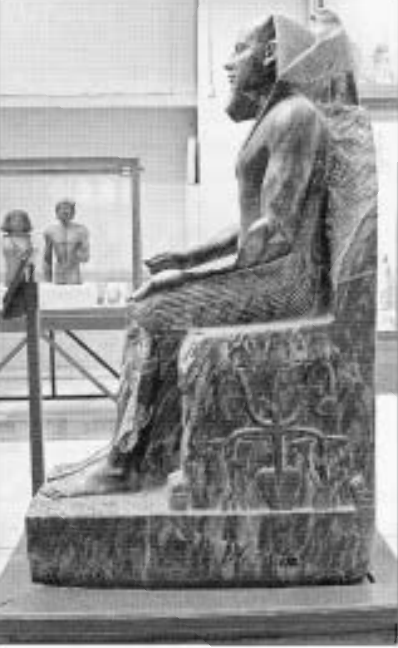
Figure 3 Chephren Gneiss life-size statue of Khafra in the Egyptian Museum, Cairo (Fourth Dynasty).